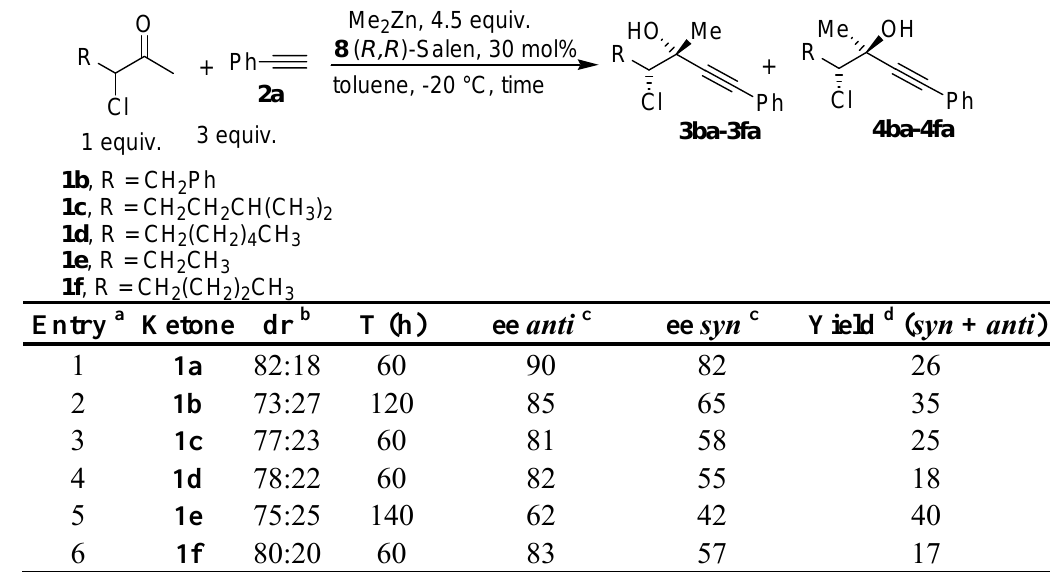
Table 3. Stereoselective addition of phenylacetylene to a series of α -chloroketones promoted by ( R,R )-Salen